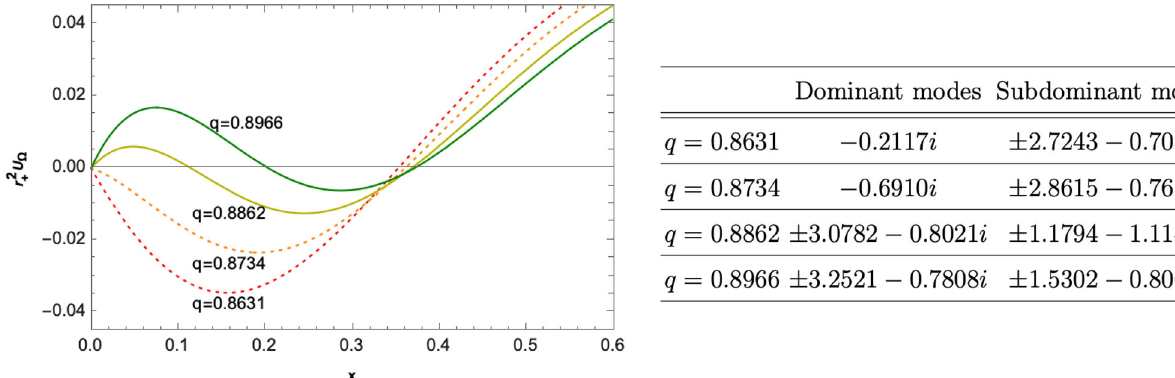
(cid:18) L (right). The solid/dashed lines represent the potentials with a bar- rier/dip near the event horizon, for which the complex/purely imaginary stable quasinormal modes